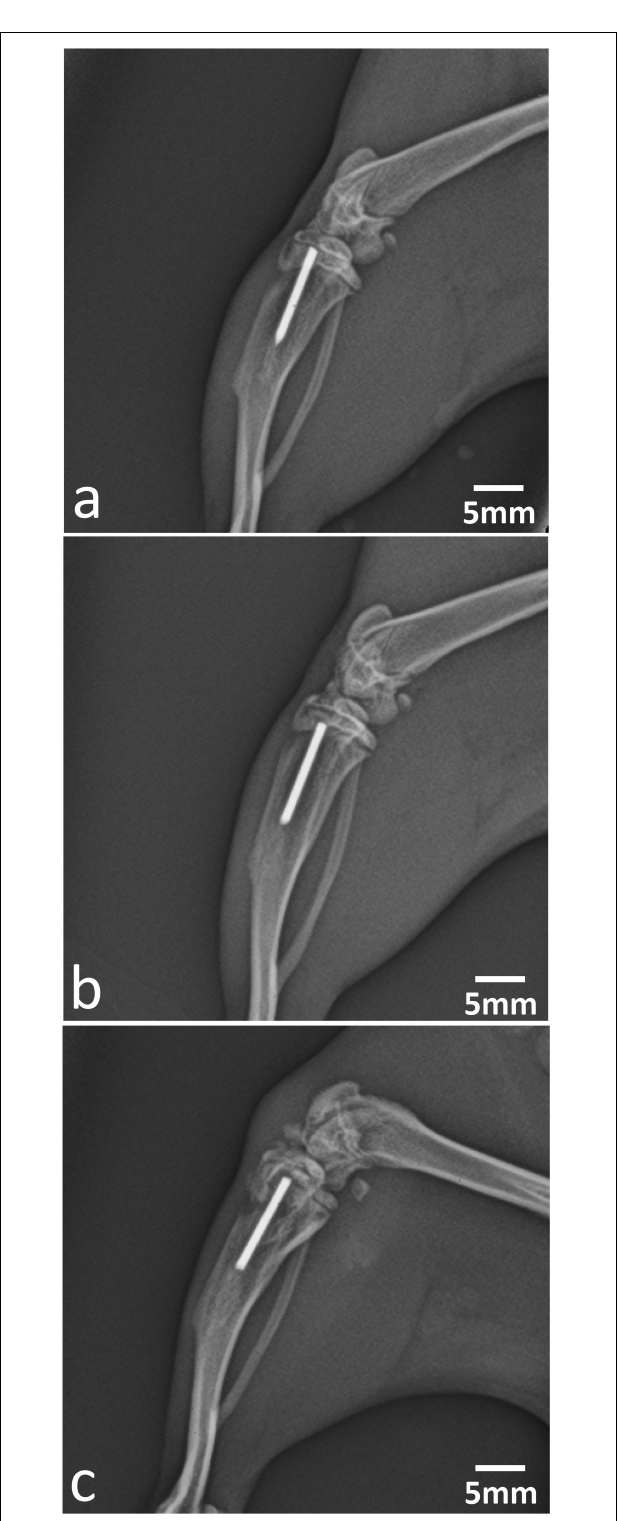
FIGURE 2 | Preterminal digital radiographic imaging of intramedullary insertion sites of: (a) control, (b) low-dose, and (c) high-dose implants at day 15 (lateral view) showing good positioning of the K-wire implants. Similar findings were observed at day 8 (images not